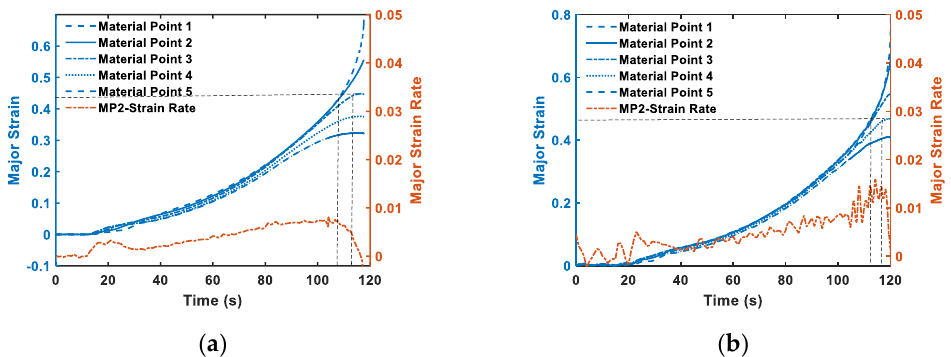
Figure 10. Major strain and strain rate evolution for two independent tests on a 70 mm wide speci- men: ( a ) the first test; ( b ) the second test.